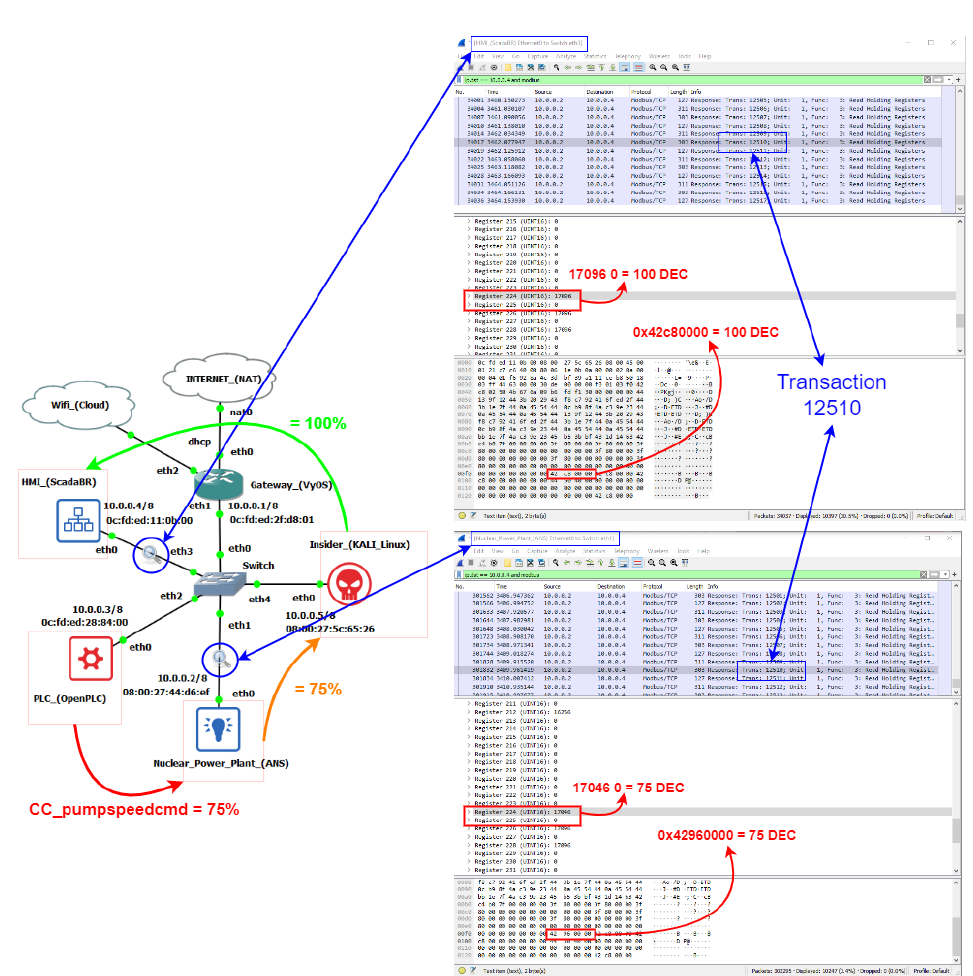
Figure 22. Attack with Wireshark packet analysis